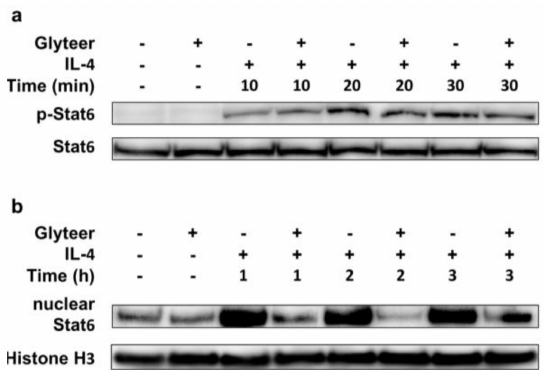
Figure 4. Glyteer treatment inhibited nuclear translocation of Stat6 induced by IL-4 stimulation without affecting the phosphorylation of Stat6 in BMDCs. ( a ) BMDCs treated with Glyteer for 24 h were stimulated with IL-4 (10 ng/mL) for 10, 20 and 30 min and then total protein or nuclear protein of the BMDCs was extracted; ( b ) BMDCs treated with Glyteer for 24 h were stimulated with IL-4 (10 ng/mL) for 1, 2 and 3 h and then total protein or nuclear protein of the BMDCs was extracted. Expression of phosphorylated Stat6 (pStat6) and Stat6 was analyzed by western blotting using anti-pStat6 antibodies. Histone H3 served as an internal loading control. The data are representative of experiments repeated three times with similar